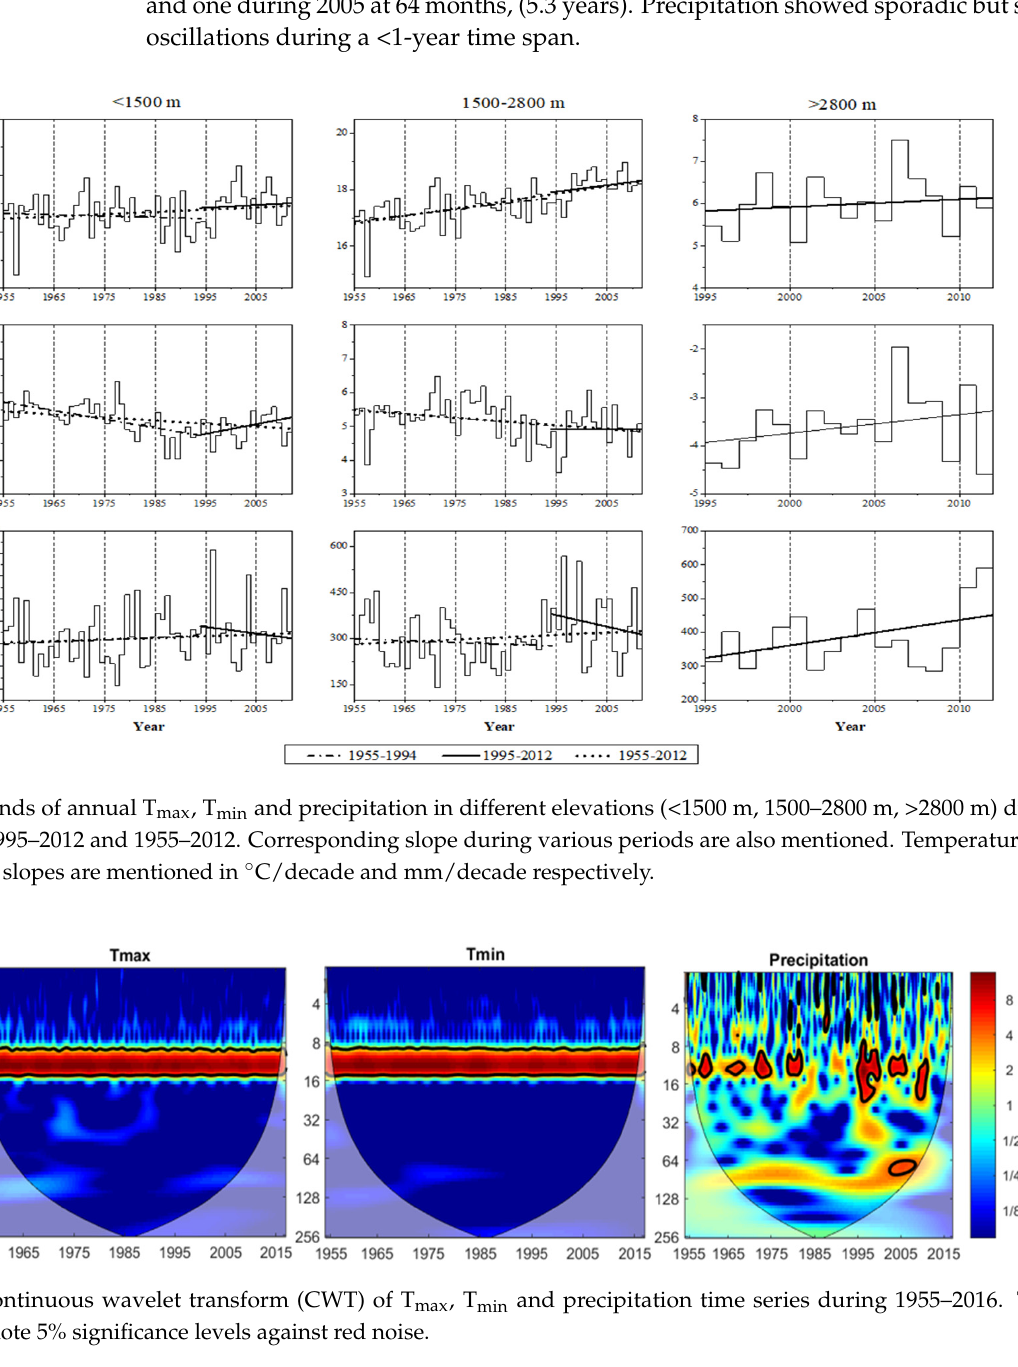
Figure 8. Continuous wavelet transform (CWT) of T max , T min and precipitation time series during 1955–2016. Thick contours denote 5% significance levels against red noise.